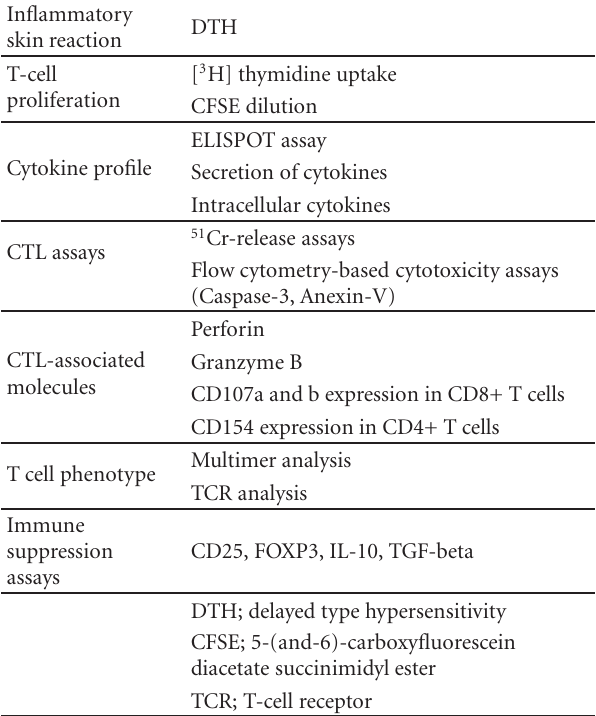
Table 1: Immunologic